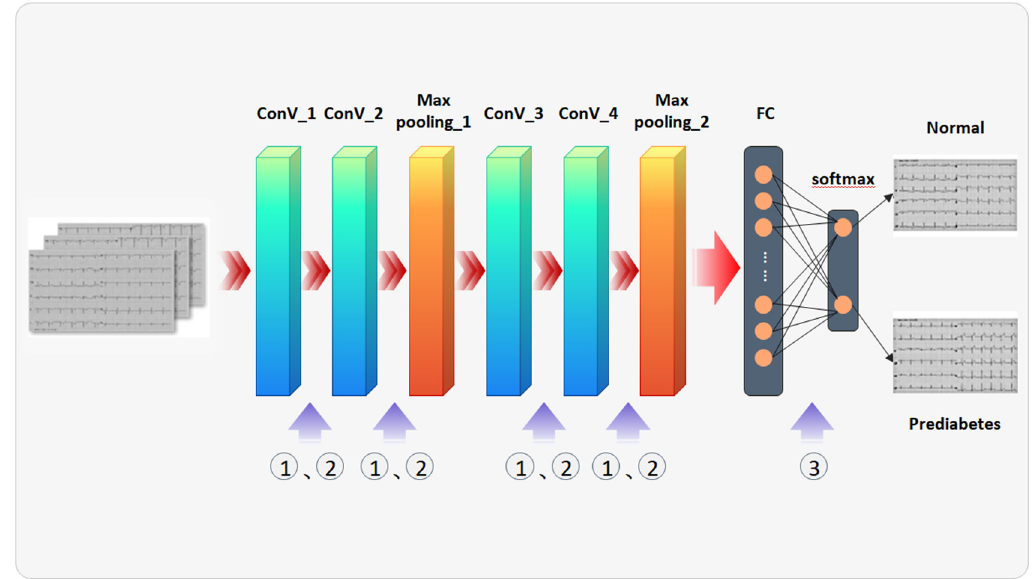
Figure 3. IGRNet architecture settings: ( 1 ) represents batch normalization; ( 2 ) represents activation functions, including ReLU, LeakyReLU, ELU, and Clipped ReLU; and ( 3 ) represents the dropout function.